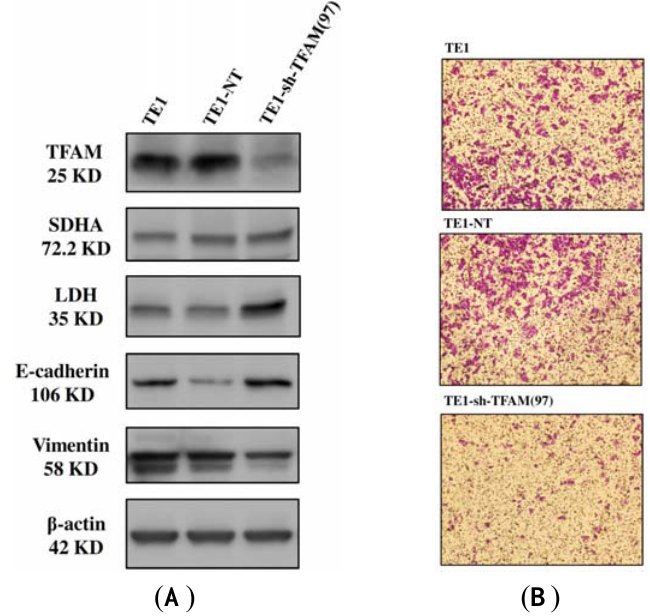
Figure 5. ( A ) Western blot analysis showed that the TFAM knockdown TE1-sh-TFAM(97) had the lowest TFAM (the first row), equal SDHA (the second row), highest LDH (the third row), highest E-cadherin (the fourth row) and lowest vimentin (the fifth row) protein expressions. The expression of beta-actin (the sixth row) was used as an internal control; ( B ) Illustrations are photographic (light microscopy) results of the trans-well migration activity among the parental TE1 cell, control TE1-NT cell, and TFAM knockdown